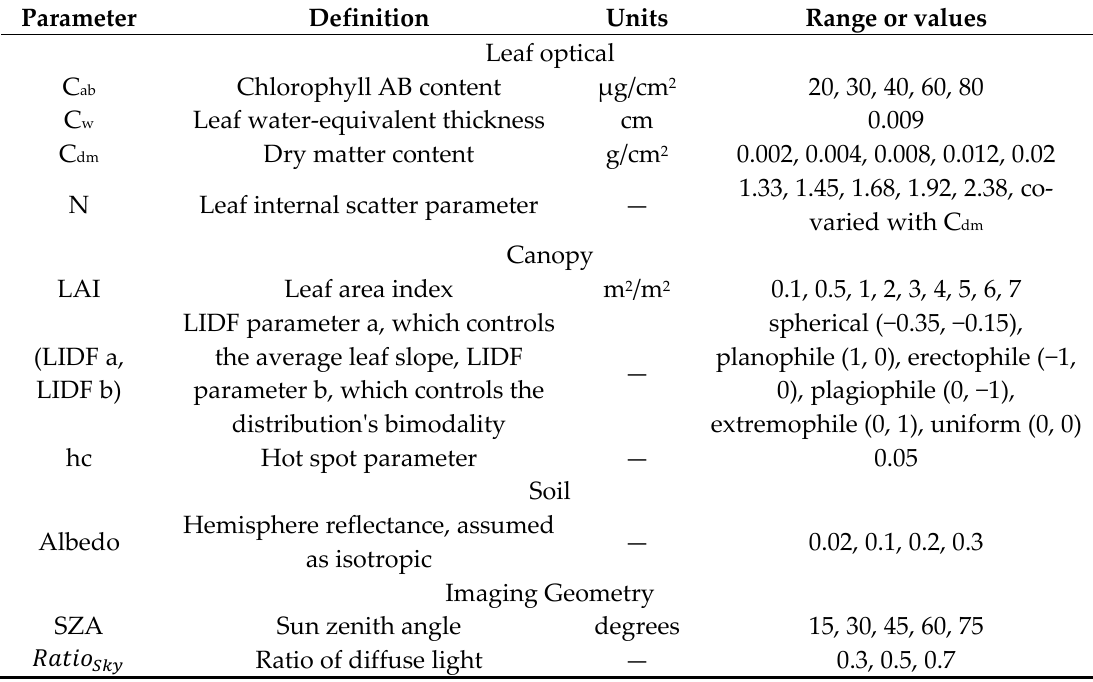
Table 3. The main input parameters used for the PROSAIL model